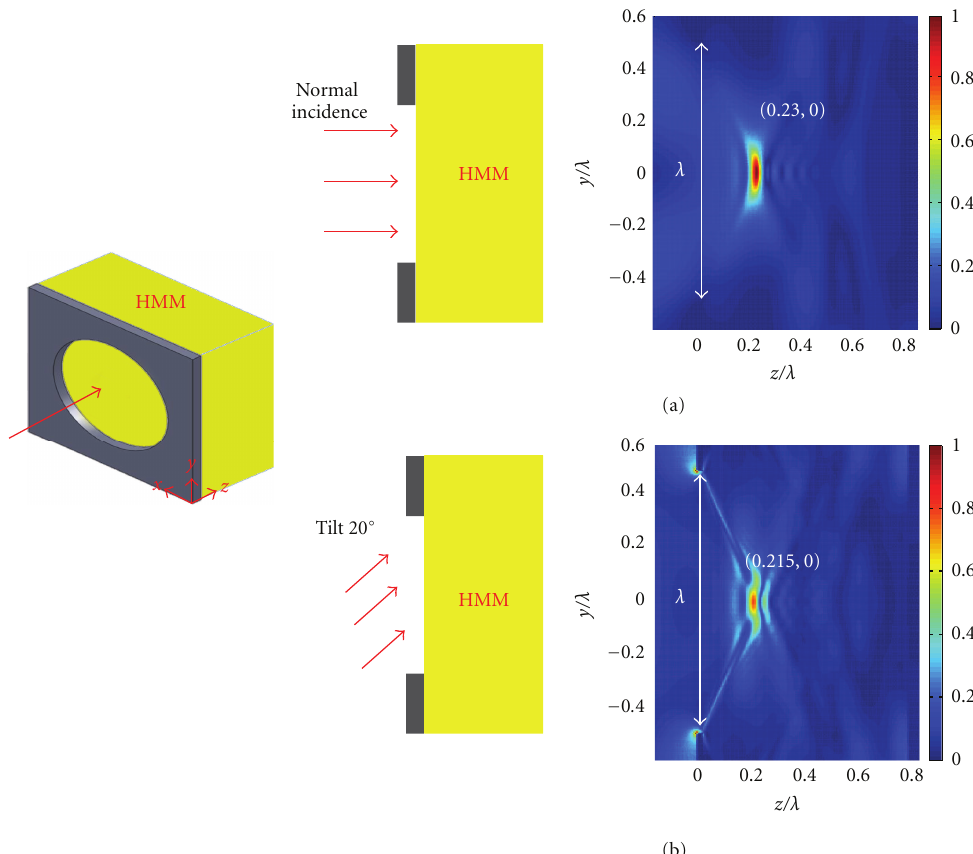
Figure 3: Numerical simulation results for focusing using HMM (a) at normal incidence (b) with tilt angle of 20 ◦ .